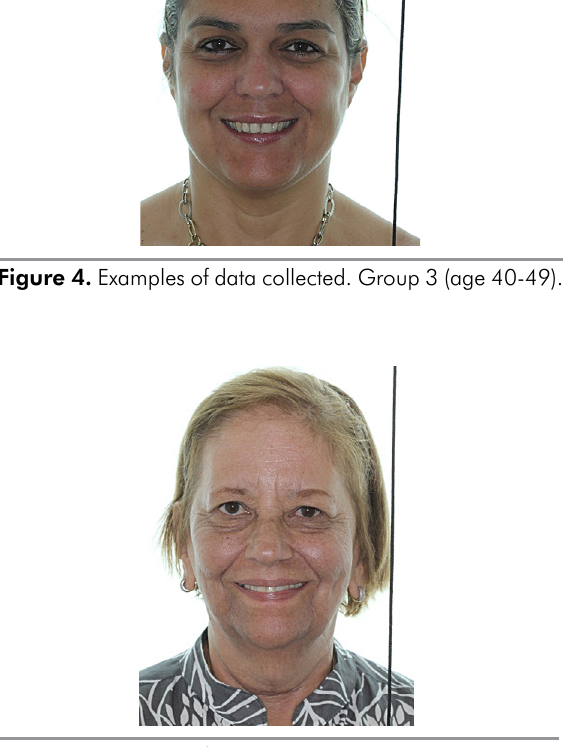
Figure 3. Examples of data collected. Group 2 (age 30-39).